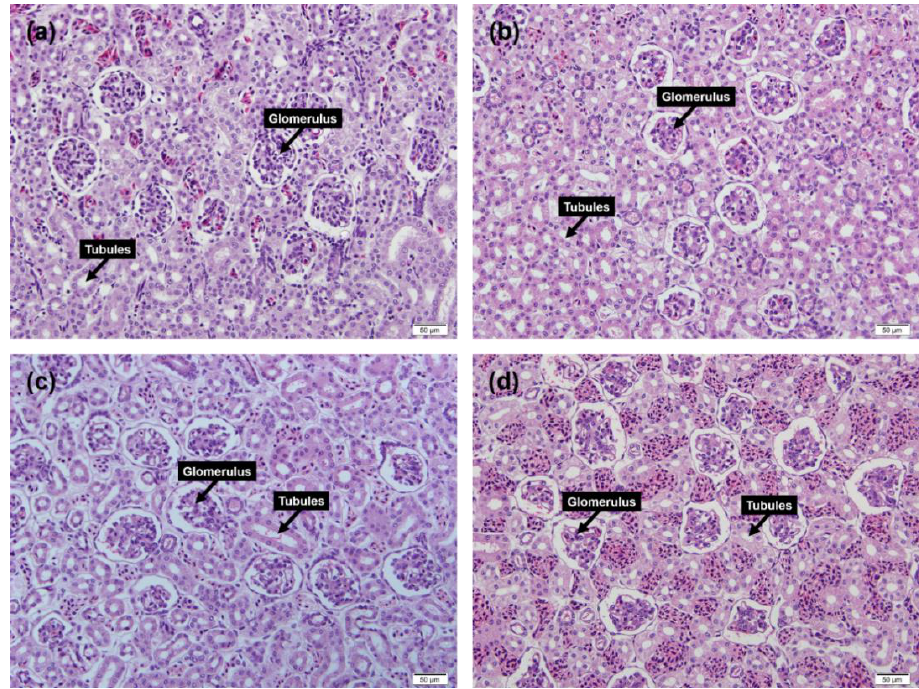
Figure 4. Renal tissue of experiment and control groups under both extreme and moderate conditions: ( a ) renal tissue of the experimental group under the severe condition, ( b ) renal tissue of the control group under the severe condition, ( c ) renal tissue of the experimental group under the moderate condition, and ( d ) renal tissue of control group under the moderate condition. We analyzed histological abnormalities of the glomerulus and tubules.